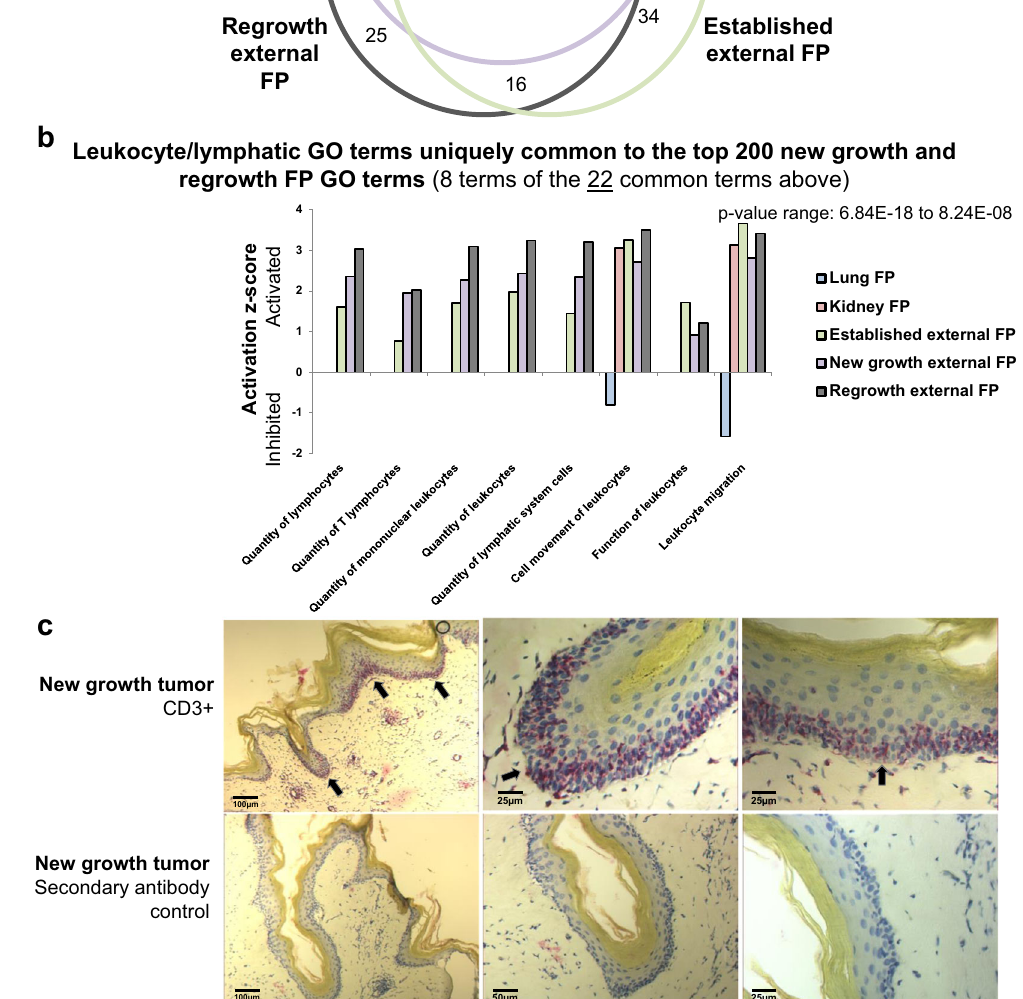
Fig. 3 Transcriptomic- and histological-based immune pro fi ling of fi bropapillomatosis tumors. a Overlap of the top 200 disease-associated GO terms associated with transcripts differentially expressed in different growth stages of external FP tumors (new growth, regrowth, established), as detected by IPA, ranked by P value (calculated by right-tailed Fisher ’ s exact test, with Benjamini – Hochberg correction). Both activated and inhibited GO terms for each tumor type when it was compared to its healthy tissue source were included. b Activation/inhibition z s cores for eight (the leukocyte/lymphatic-associated GO terms) out of the 22 disease GO terms uniquely common to the top 200 ranked GO terms of early fi bropapillomatosis (new growth and regrowth, see a ), shown for all tumor types. Some of these GO terms were called for lung, kidney and/or established external tumors (as shown), although they fell outside of the top 200 ranked GO terms called for these three tumor types. c CD3 antibody-based staining (red/purple) of T-lymphocyte in fi ltration in new growth tumor tissue, nuclei are counterstained with hematoxylin (blue staining). Selected positive CD3 stained areas are indicated by black